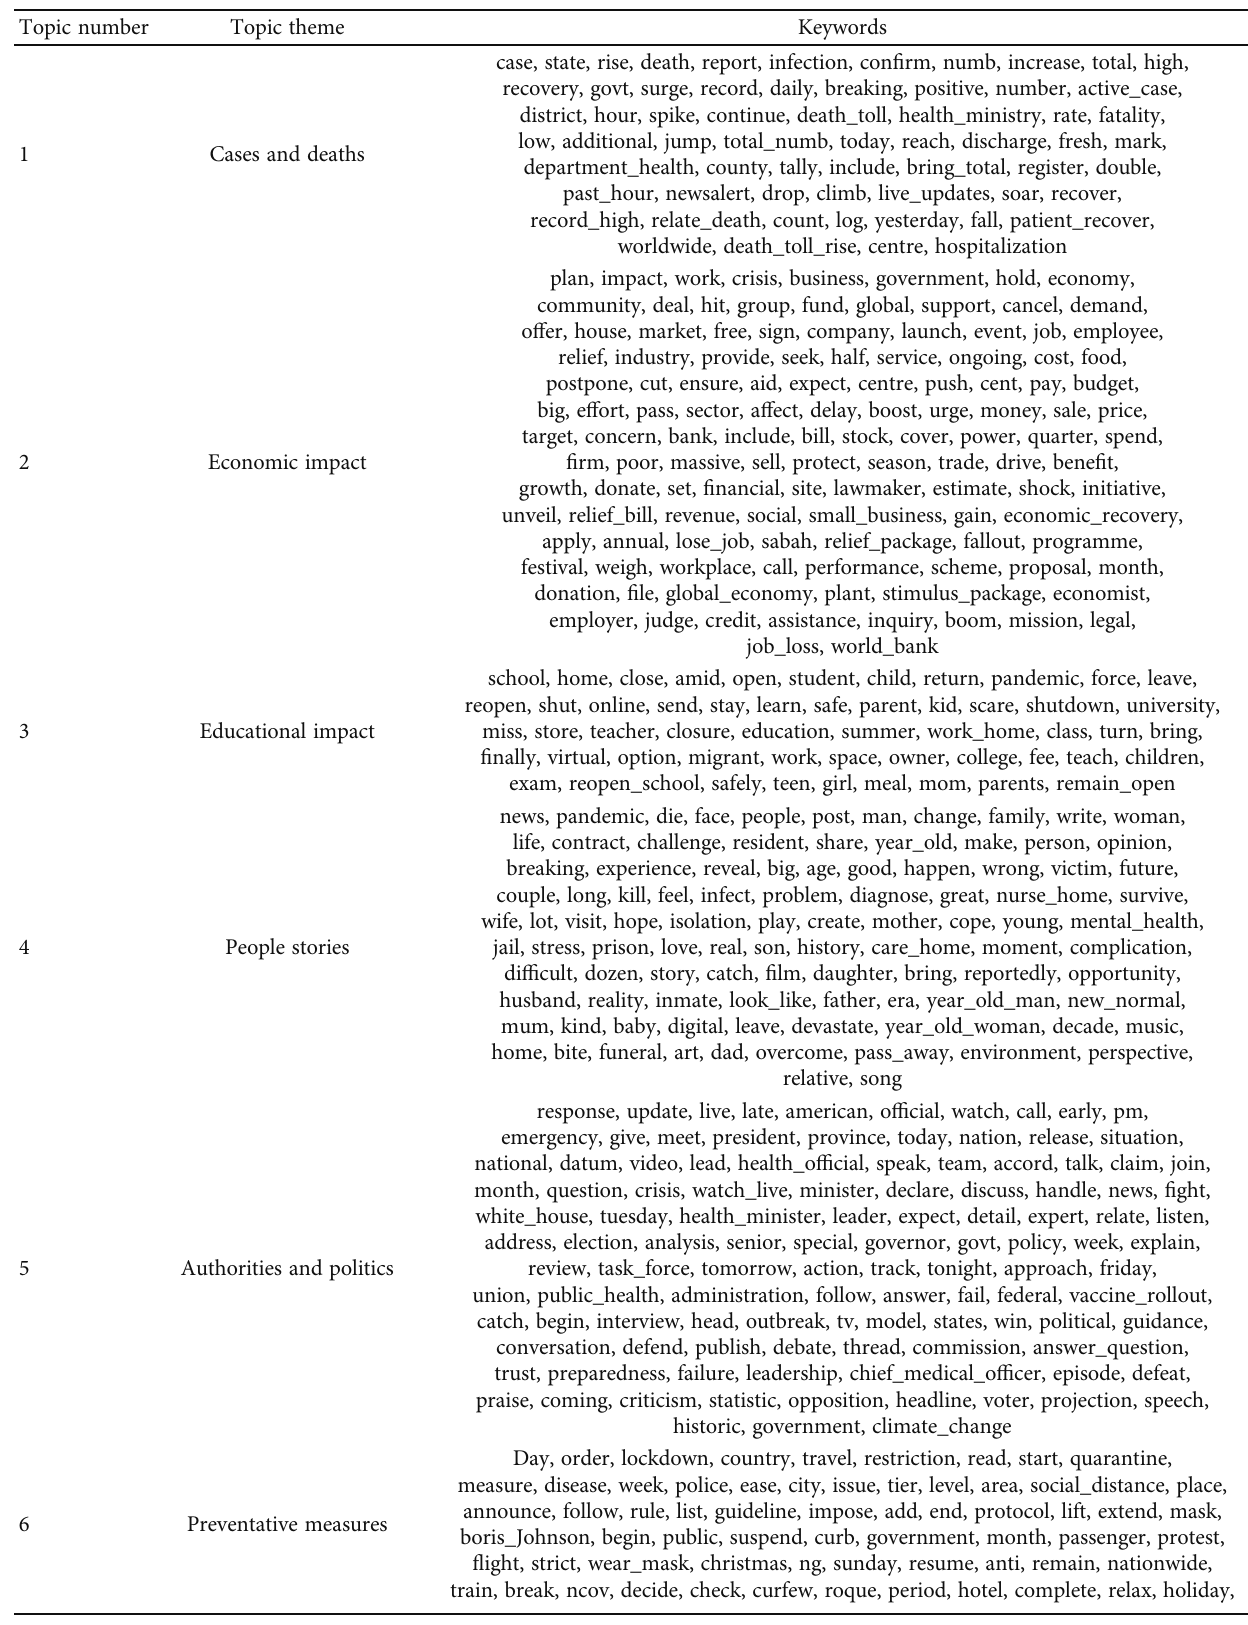
Table 2: Topic classi fi cation: topics and